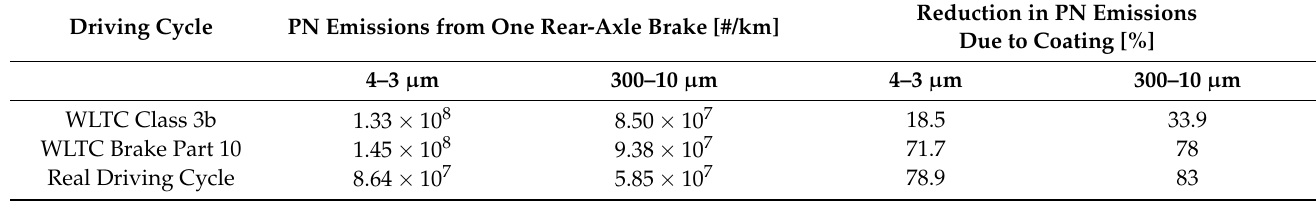
Table 3. Particle number emission indices for three driving cycles and particle number reductions resulting from coating.